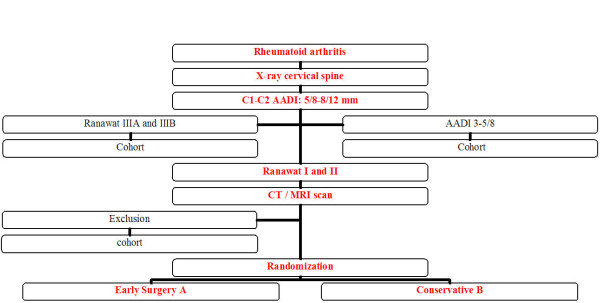
The recruitment and selection of patients for the randomization procedure of the Delphi trial is shown.